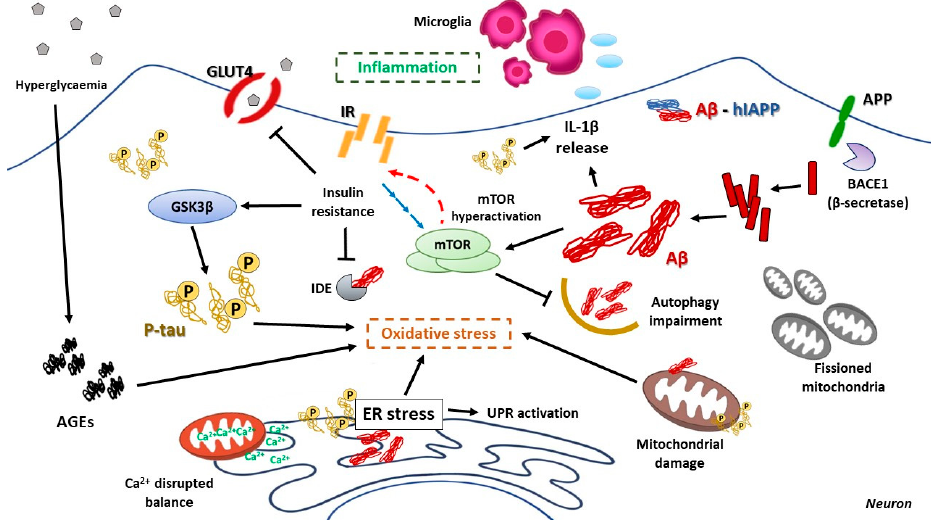
Figure 5. Hallmarks of neuron failure in AD. Neuronal alternative processing of APP through β -secretase (BACE1) origins intracellular A β 40-42 aggregates that will origin extracellular amyloid plaques. In parallel, microtubule-associated protein tau protein aberrant phosphorylation drives to cytoplasmic neurofibrillary tangles formation. Brain insulin resistance reduces GLUT4 glucose transporter activity and decreases insulin-degrading enzyme activity (IDE); A β aggregates impaired insulin and IGF-I signaling cascade. Insulin resistance results in GSK3 β activation and tau hyperphosphorylation. The hyperglycaemic status also induces AGEs which are known to impair A β clearance and promote GSK3 β -mediated tau phosphorylation. Both proteins can induce ER stress, chronic UPR activation, and neuronal apoptosis. A β and p-tau are known to disrupt the mitochondrial respiratory chain, increase ROS, alter Ca2+ balance and lead mitochondria to an irreversible fission status; furthermore, Parkin-mediated mitophagy is impaired in AD by A β and p-tau. As it happens in T2DM, insulin resistance-mediated mTOR hyperactivation affects insulin signaling, impairs neurogenesis and synaptic plasticity, and impede correct autophagy-mediated A β and p-tau degradation; both peptides could also affect the lysosomal function and compromise autophagosomes clearance. A β aggregates and p-tau tangles are known to trigger NLRP3-mediated inflammasome activation, thus releasing IL-1 β and other cytokines, and inducing proinflammatory microglia recruitment. And if that were not enough, hIAPP could aggravate all these events, even worsen the situation by the generation of crossseeding heterocomplexes of A β -hIAPP aggregates.